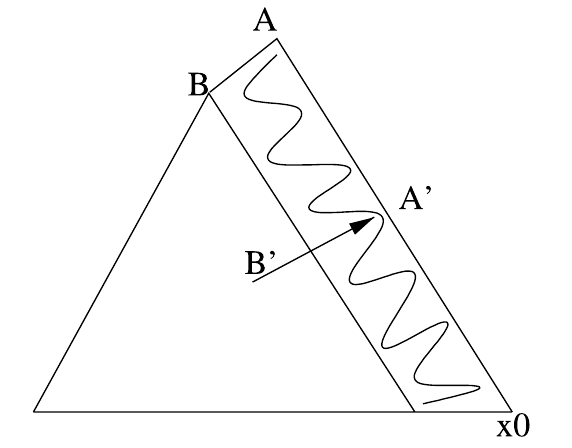
Fig. 1 Graphical representation of the inequality constraints with respect to the Möbius transform. We consider all B ′ ⊆ B and then A � = B { x 0